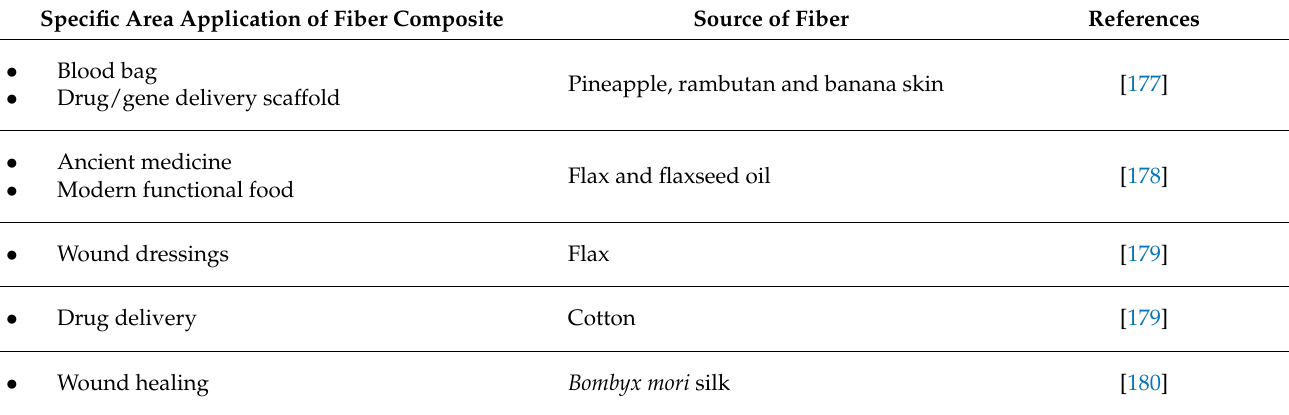
Figure 4. Potential application of natural fibers in many sectors such as ( a ) aerospace, ( b ) automotive, ( c ) marine such as boat hulls, ( d ) building and construction such as insolation board, ( e ) sport and leisure goods, ( f ) electronic appliances such as handphone casing, ( g ) paper and packaging, ( h ) textile, ( i ) biomedical, and ( j ) military fields. Table 2. Application of natural fiber composites in biomedical